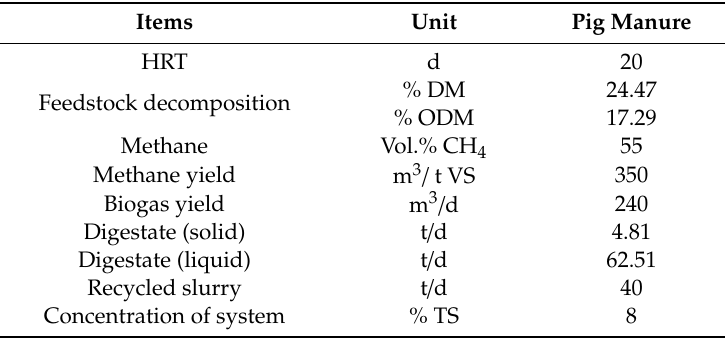
Table 1. Characterizations of the biogas subsystem and feedstock. Items